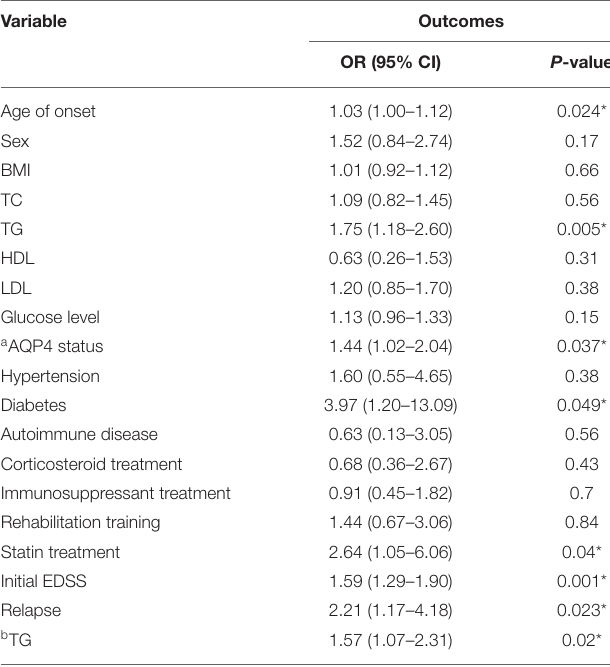
TABLE 2 | Univariate logistic regression analysis of factors associated with the outcomes of NMOSD patients. Variable